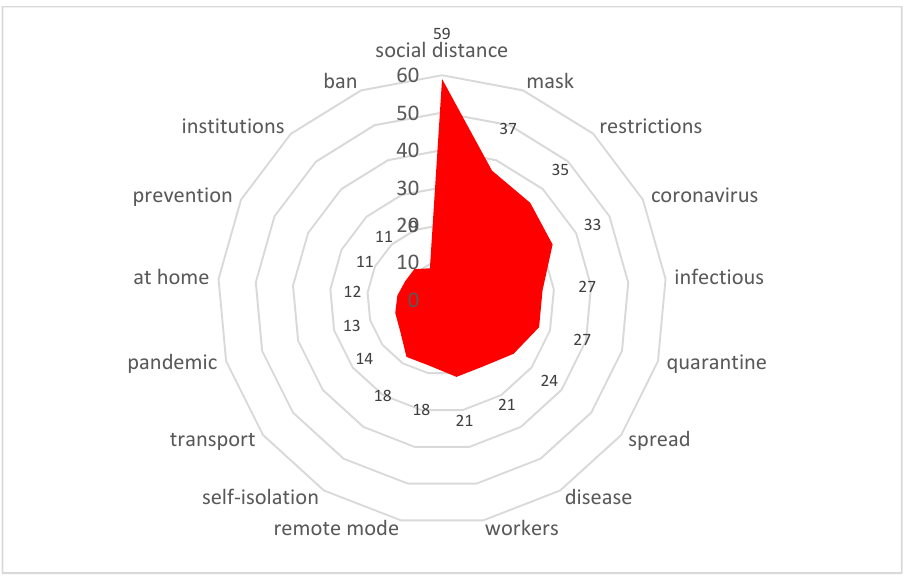
Figure 15. Associative network for stimulus distance learning